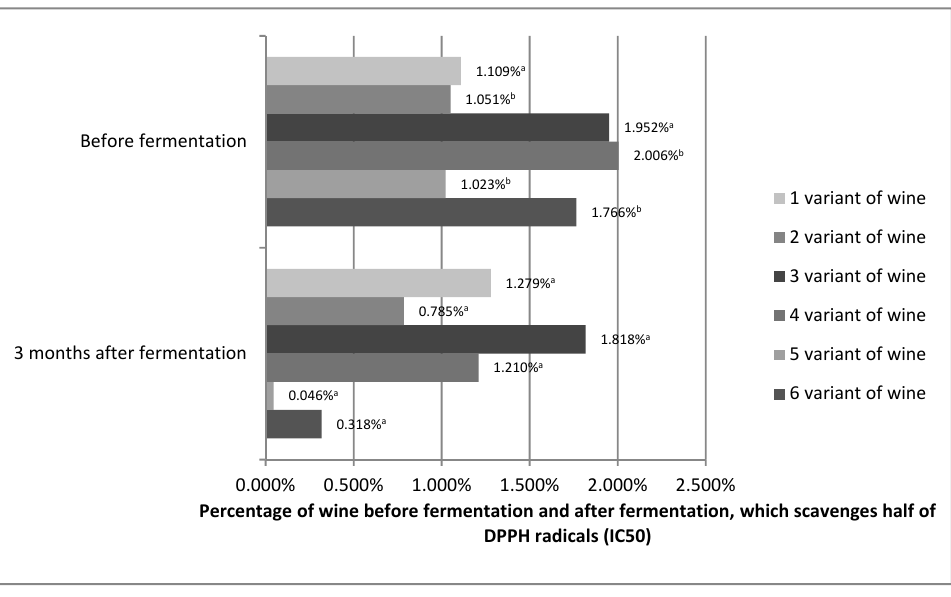
Figure 3. Percentage of wines from Rosa rugose fruits before fermentation and 3 months after fermentation, which scavenges half of the DPPH radicals (IC50). The values with different superscript letters are significantly different ( p < 0.05).